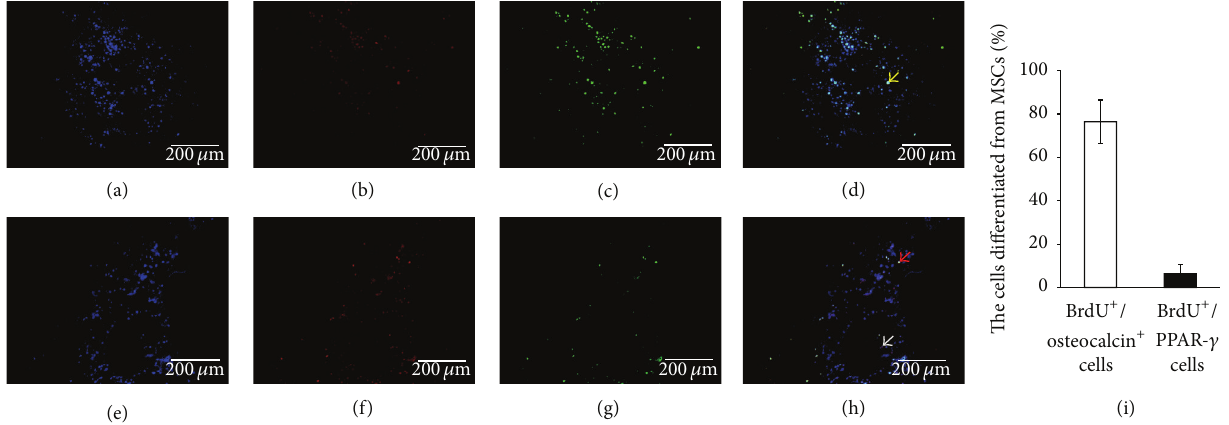
Figure 4: Osteogenic and adipogenic differentiation of MSCs with intra-arterial infusion in necrotic field of femoral head. BrdU (green) and osteocalcin (red) were analyzed by double-immunofluorescent analysis in the necrotic region of MSC-transplanted femoral heads. (a) DAPI (blue); (b) BrdU (red); (c) osteocalcin (green); (d) an overlay of (a), (b), and (c); (e) DAPI (blue); (f) BrdU (red); (g) PPAR- 𝛾 (green); (h) an overlay of (e), (f), and (g). Most of the BrdU-positive MSCs in the necrotic region of MSC-transplanted femoral heads costained together with osteocalcin but a few cells costained together with PPAR- 𝛾 . Yellow arrow shows osteoblasts differentiated from MSCs, red arrow shows adipocytes differentiated from MSCs, and grey arrow shows BrdU-positive cells which did not differentiate to lipocytes. Scale bar 200 𝜇 m . BrdU + /osteocalcin + cells in MSCs group ( 76.42 ± 10.14 %) were significantly higher than BrdU + /PPAR- 𝛾 + cells over total BrdU + cells ( 6.36 ± 4.41 %) after eight-week treatment ( 𝑝 < 0.05 )